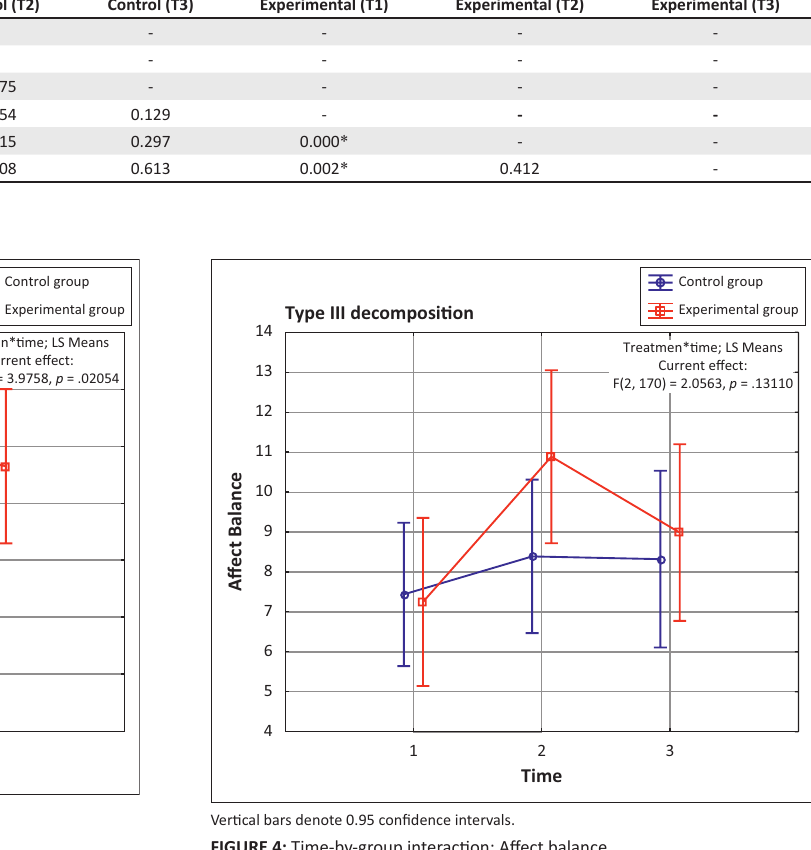
TABLE 3: Least Significance Difference test (post-hoc) results for ASE (Effect: Group * time). Treatment Time